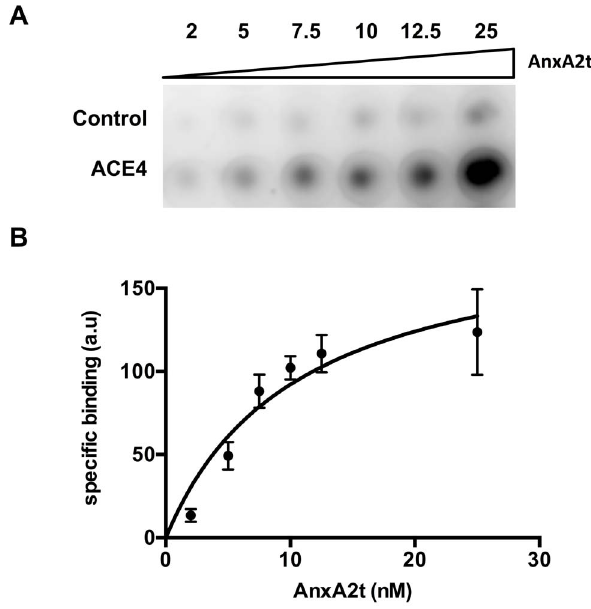
Figure 3. Filter binding assay of the ACE4 aptamer with purified hetero-tetramer Annexin A2 (AnxA2t). A) Different concentrations (from 2 to 25 nM) of the [ 32 P] 5 9 -end radiolabeled ACE4 aptamer or scramble sequence were incubated with purified AnxA2t in the presence of a large excess of tRNA. Oligonucleotides bound to the protein were recovered on nitrocellulose filters and quantified by Phosphorimaging. B) Binding curve of the ACE4 aptamer on AnxA2t used for the evaluation of the binding constant (K d =10.5 6 4.6 nM). Error bars represent standard deviation of triplicate.